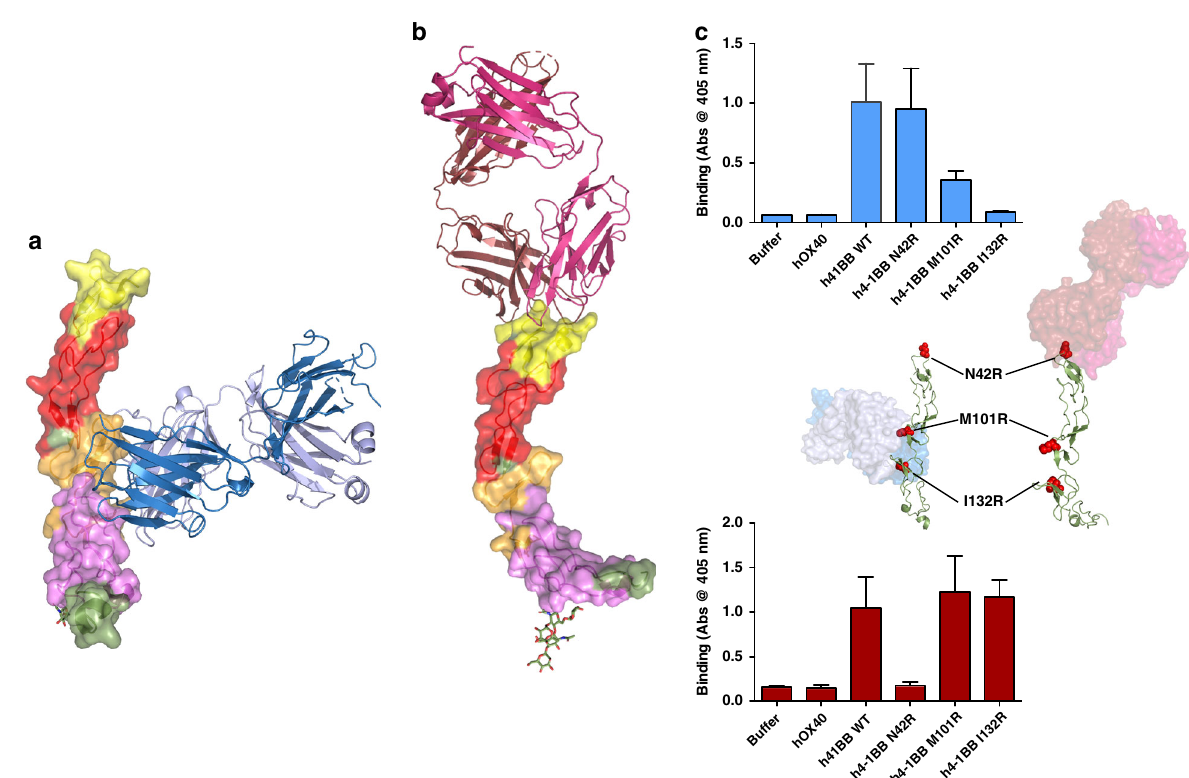
Fig. 4 4-1BB bound to utomilumab and urelumab. a Utomilumab Fab bound to 4-1BB at the junction of CRD-3 and CRD-4. b Urelumab Fab bound to 4-1BB at the N-terminal portion of CRD-1. c Receptor mutants N42R or M101R and I132R were chosen to disrupt respective urelumab or utomilumab binding sites. Urelumab or utomilumab antibody was incubated with captured wild type or mutant h4-1BB receptor and subsequently washed before binding was detected by the addition of anti-human IgG Fc-HRP. Data shown as mean with s.d. ( N = 3). As predicted by the antibody-bound structures, utomilumab shows reduced binding to M101R and I132R h4-1BB mutants but not N42R while urelumab shows the opposite trend. hOX40 was used as negative control. Structures depict position of receptor mutants. Receptors are shown in forest green cartoon with mutation sites highlighted in red spheres. Utomilumab (blue), urelumab (red) are shown in transparent